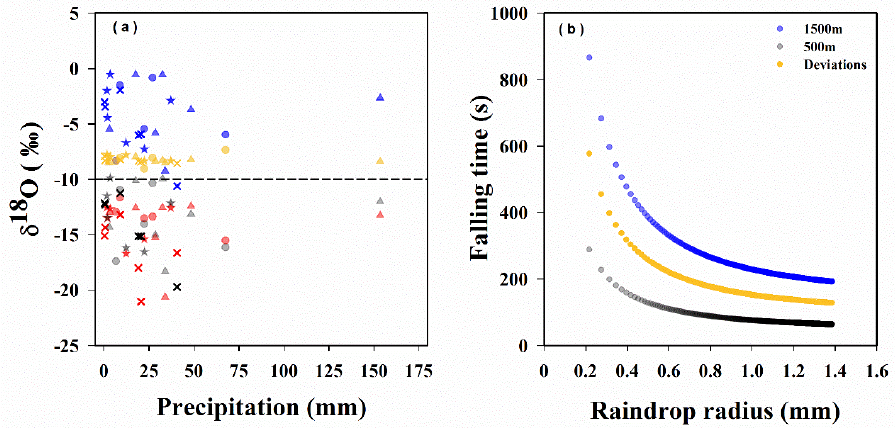
Figure 6. ( a ) Relation between δ 18 O and precipitation. The isotopic composition of precipitation ( δ p ) and water vapor ( δ v ) are represented by blue and red, respectively. The equilibrium isotopic composition of water vapor is in gray and the isotopic change of water under the cloud base is in yellow. Circle, triangle, cross and star represent rain event styles S1, S2, S3 and S4, respectively. ( b ) Falling time for raindrops of different sizes from 1500 and 500 m.